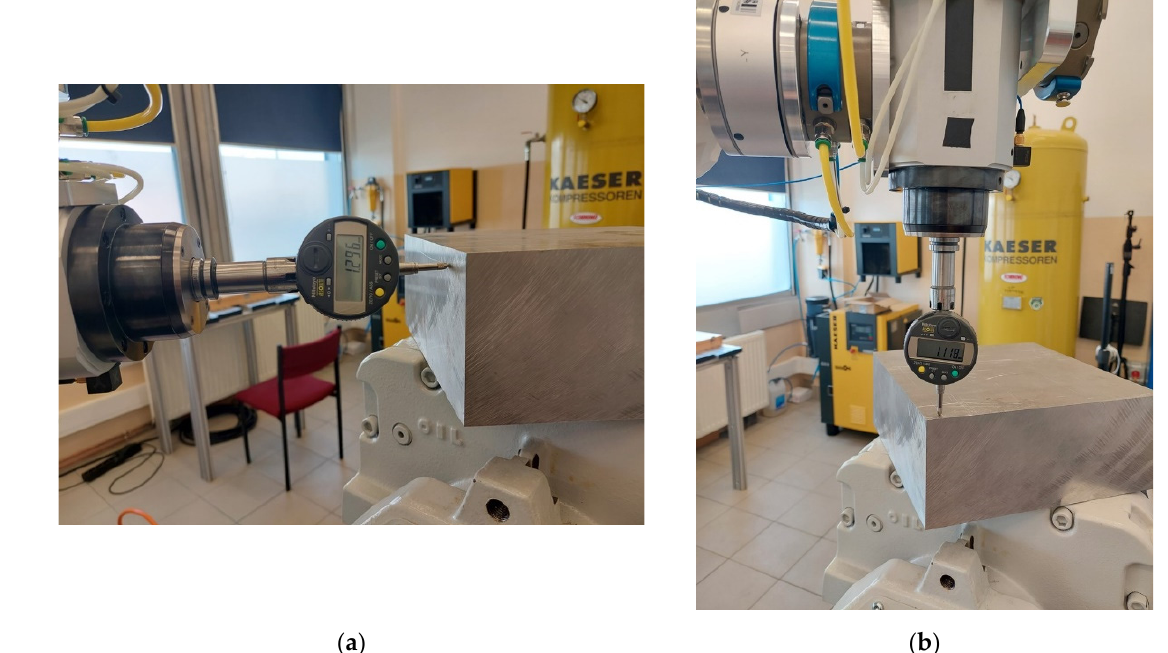
Figure 20. The movement of the robot’s TCP to the defined points: ( a ) TCP movement to point 1; ( b ) TCP movement to point 2.